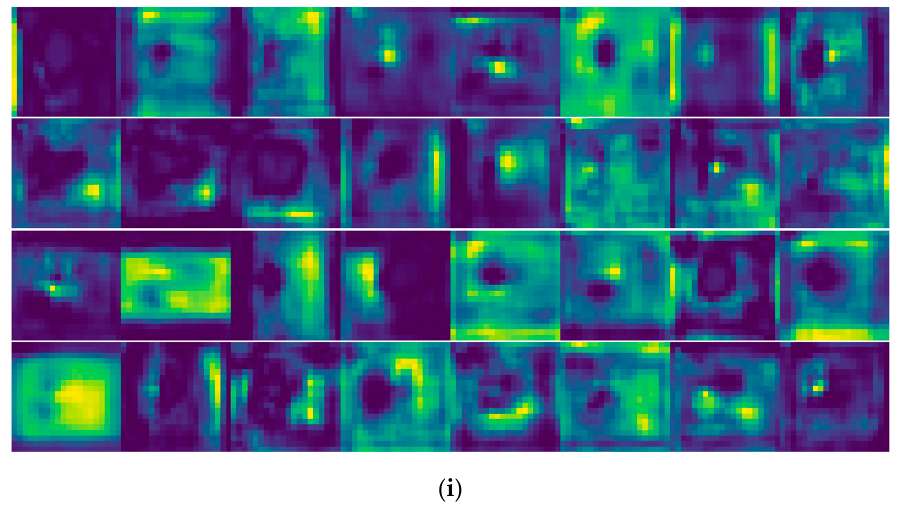
Figure 6. Visualization of Feature maps: ( a ) is the input image; ( b ) and ( c ) are the eighth and the twenty-third layer of YOLOv5s, respectively; ( d ) and ( e ) are the eighth and the twenty-third layer of YOLOv5s-BACKBONE-GHOST, respectively; ( f ) and ( g ) are the eighth and the twenty-third layer of YOLOv5s-HEAD-GHOST, respectively; ( h ) and ( i ) are the eighth and the twenty-third layer of YOLOv5s-ALL-GHOST, respectively.